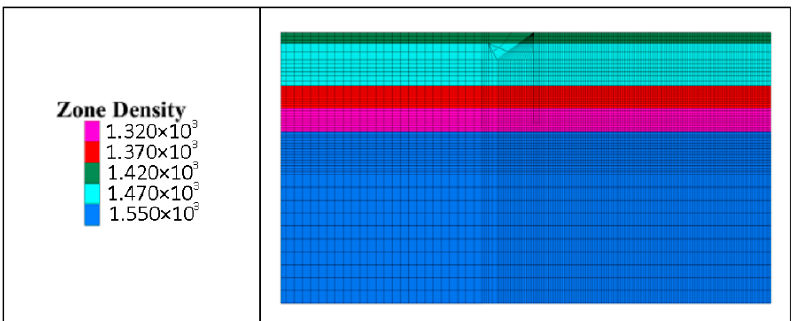
Figure 16. FLAC3D mesh model. Table 2. Soil